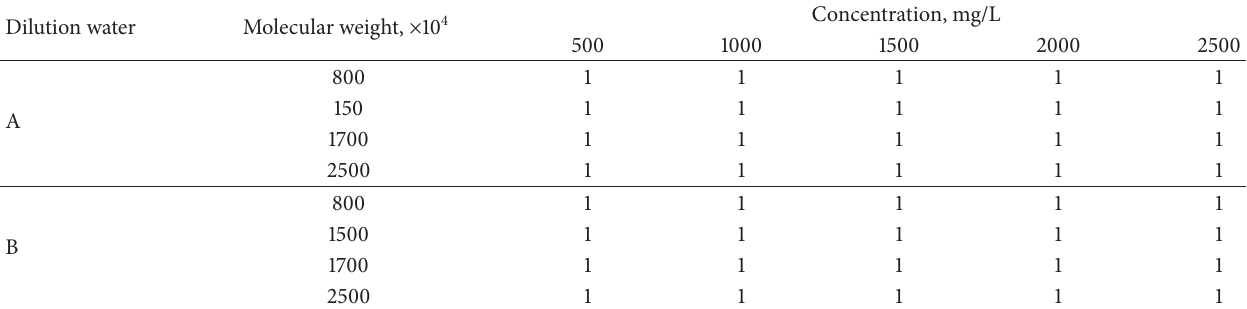
Table 8: The matching relationship for reservoirs with permeability more than 928 × 10 −3 𝜇 m 2